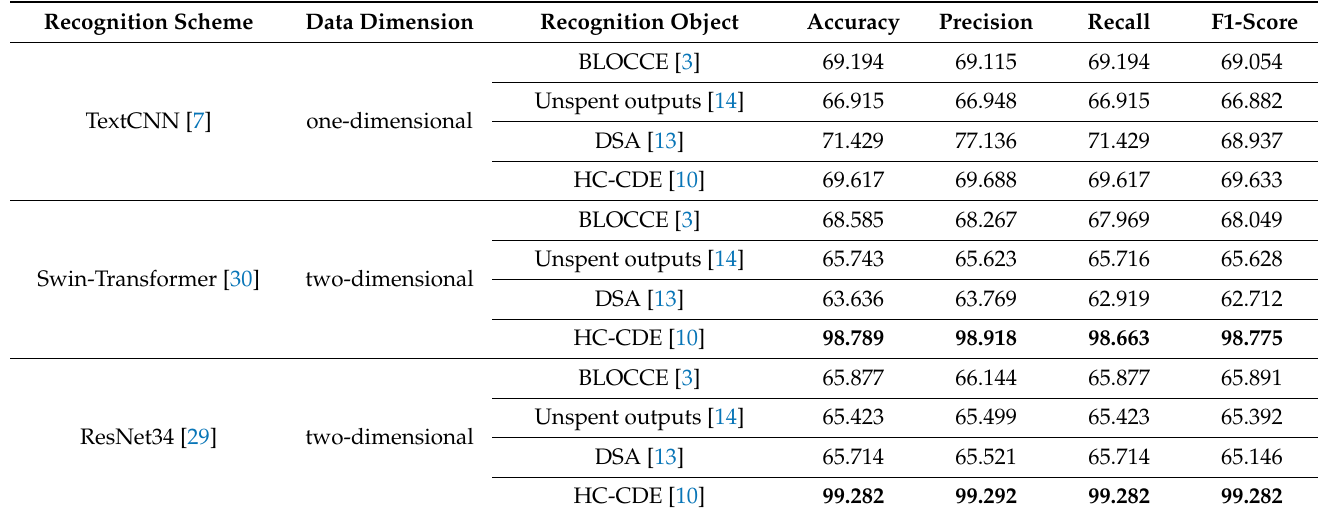
Table 1. Results of convert transaction